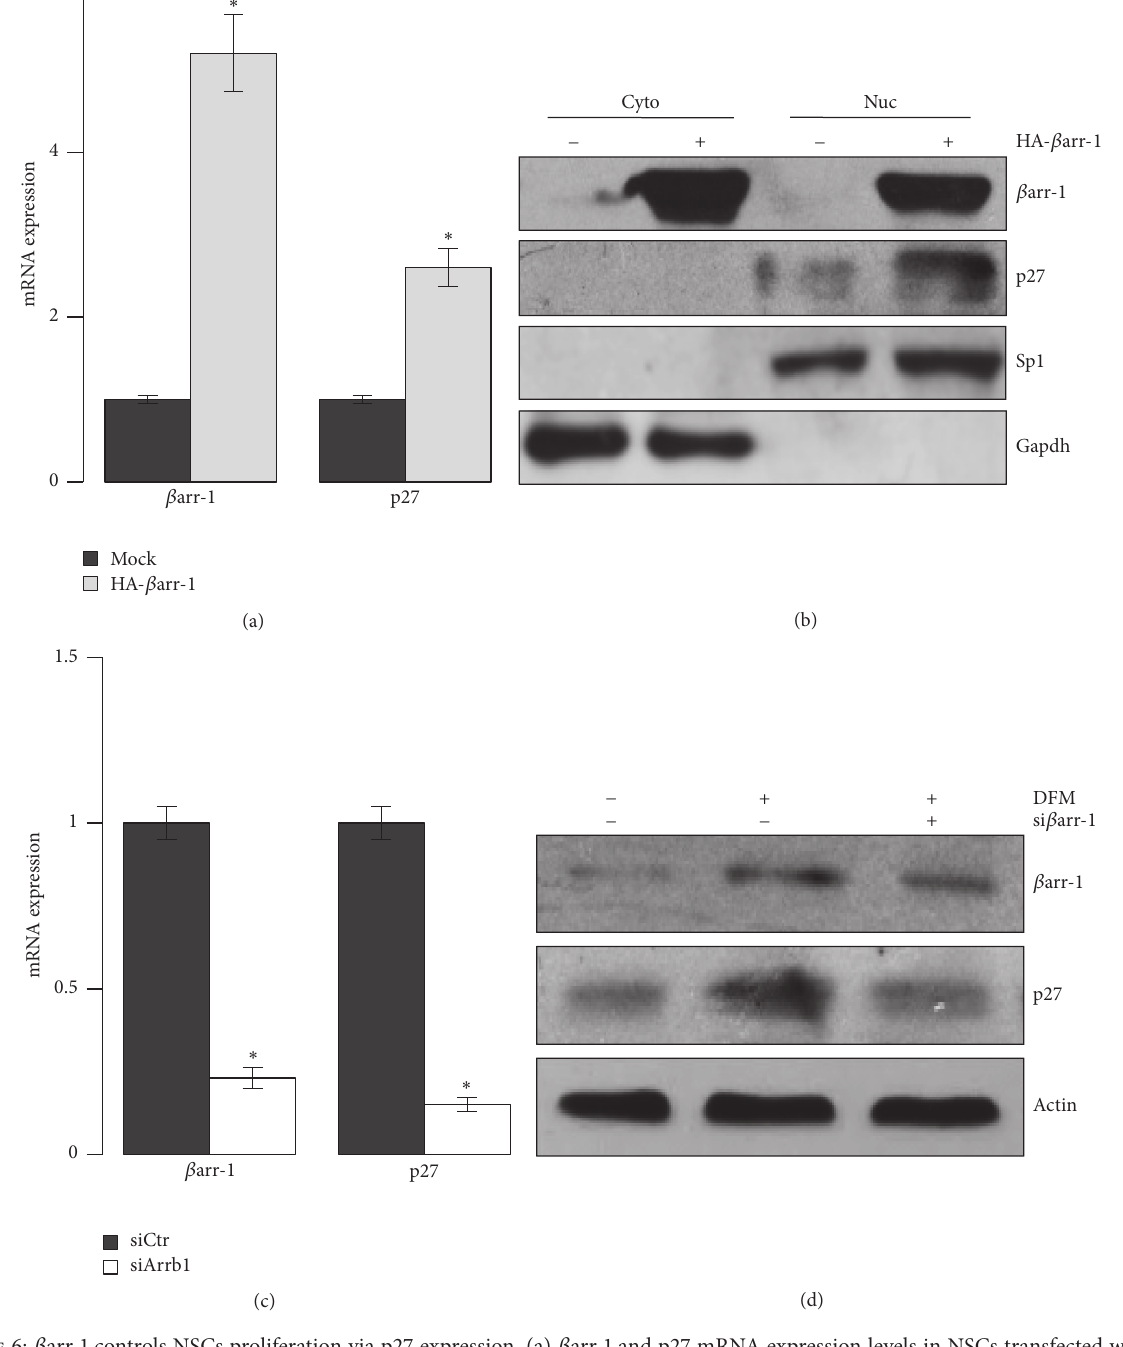
Figure 6: 𝛽 arr-1 controls NSCs proliferation via p27 expression. (a) 𝛽 arr-1 and p27 mRNA expression levels in NSCs transfected with the HA- 𝛽 arr-1 plasmid for 48 hrs. (b) Subcellular localization of 𝛽 arr-1 and p27 proteins in NSCs transfected with the HA- 𝛽 arr-1 plasmid and analyzed 48hrs after transfection. Proteins are shown in the cytosolic (Cyto) and nuclear (Nuc) fractions. Sp1: nuclear loading control; Gapdh: cytoplasmic loading control. Representative Western blot images from 3 independent experiments. (c) 𝛽 arr-1 and p27 mRNA expression levels in NSCs transfected with control siRNA (siCtr) or 𝛽 arr-1 siRNA (si 𝛽 arr-1) cultured for 24 hrs in DFM. (d) Western blot showing endogenous 𝛽 arr-1 and p27 protein levels in NSCs transfected with control siRNA (siCtr) or 𝛽 arr-1 siRNA (si 𝛽 arr-1) cultured for 24 hrs in DFM. Representative Western blot images from 3 independent experiments. ((a) and (c)) Data are means ± SD from 3 independent experiments. ∗ 𝑝 < 0.05